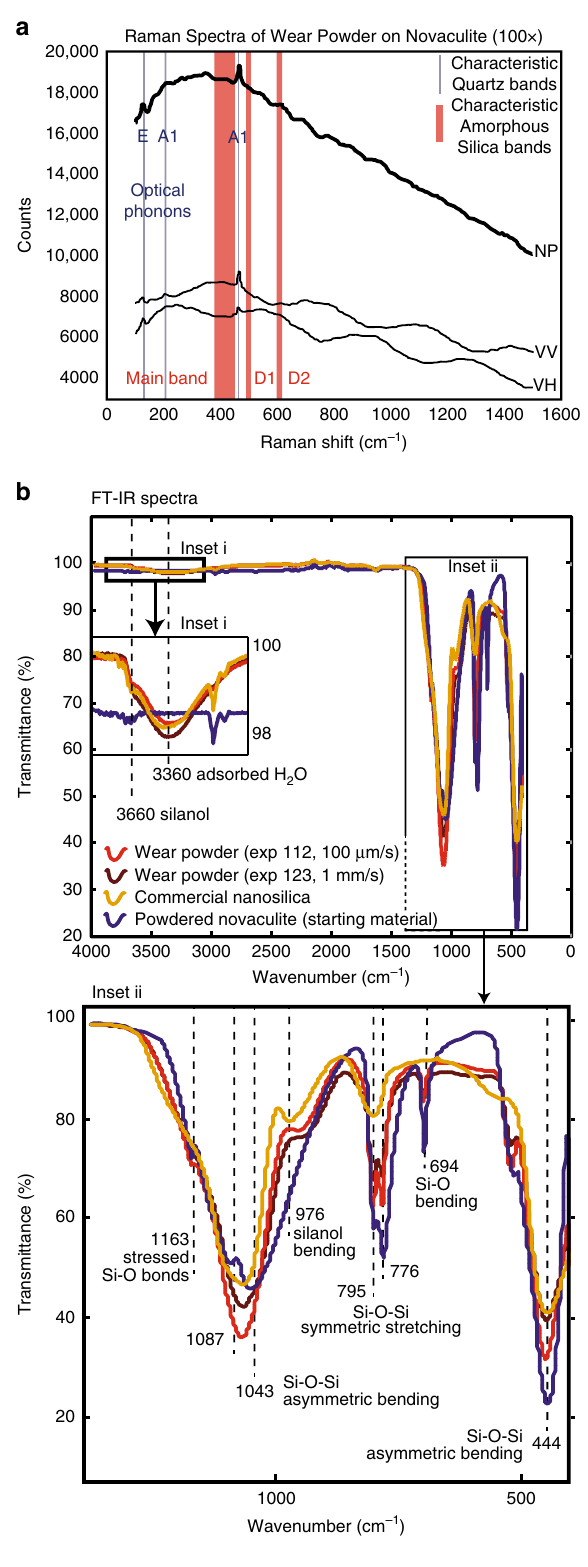
grain size, structure, composition and water content. The lack of discernible difference between the wear material formed in dif- ferent experiments requires that the differences in shear resis- tance between the moderate slip rate (100 µm/s – 1 cm/s) and fast